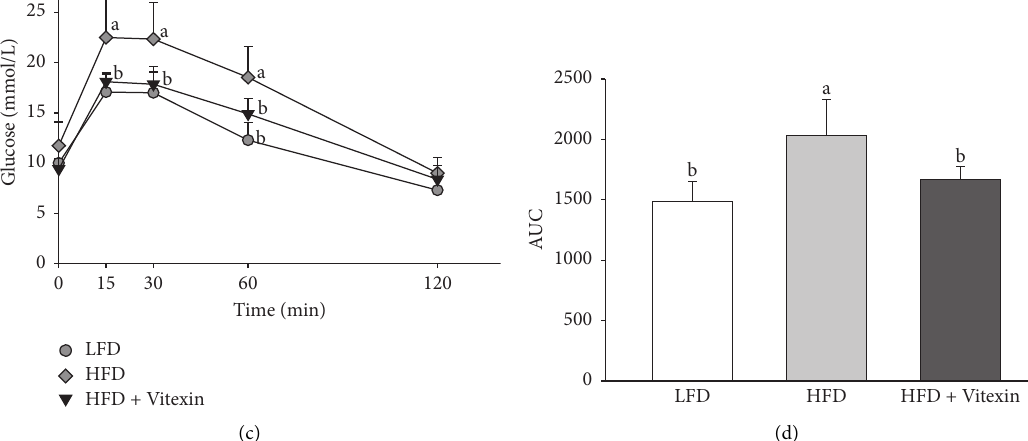
Figure 2: Influence of vitexin on insulin tolerance test (ITT) (a, b) and glucose tolerance test (GTT) (c, d). Mice were fed with low-fat diet (LFD), high-fat diet (HFD) or HFD supplemented with 5mg vitexin/kg BW/day (HFD+Vitexin) for 8 weeks. Blood was collected from the tail vein, and glucose levels were determined at 0 min. Insulin (ITT) or glucose solutions (GTT) were subsequently administered by intraperitoneal injection, and the glucose level was further measured at 15, 30, 60, and 120min after injection. Data were expressed as the mean ± SE ( n � 5 − 7). Means with different letters were significantly different at P < 0 . 05.